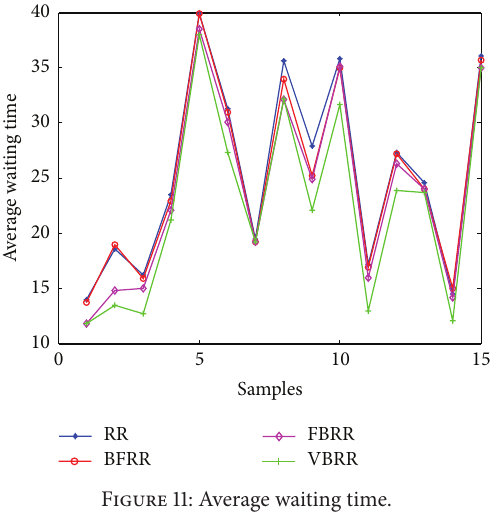
Figure 11: Average waiting time.